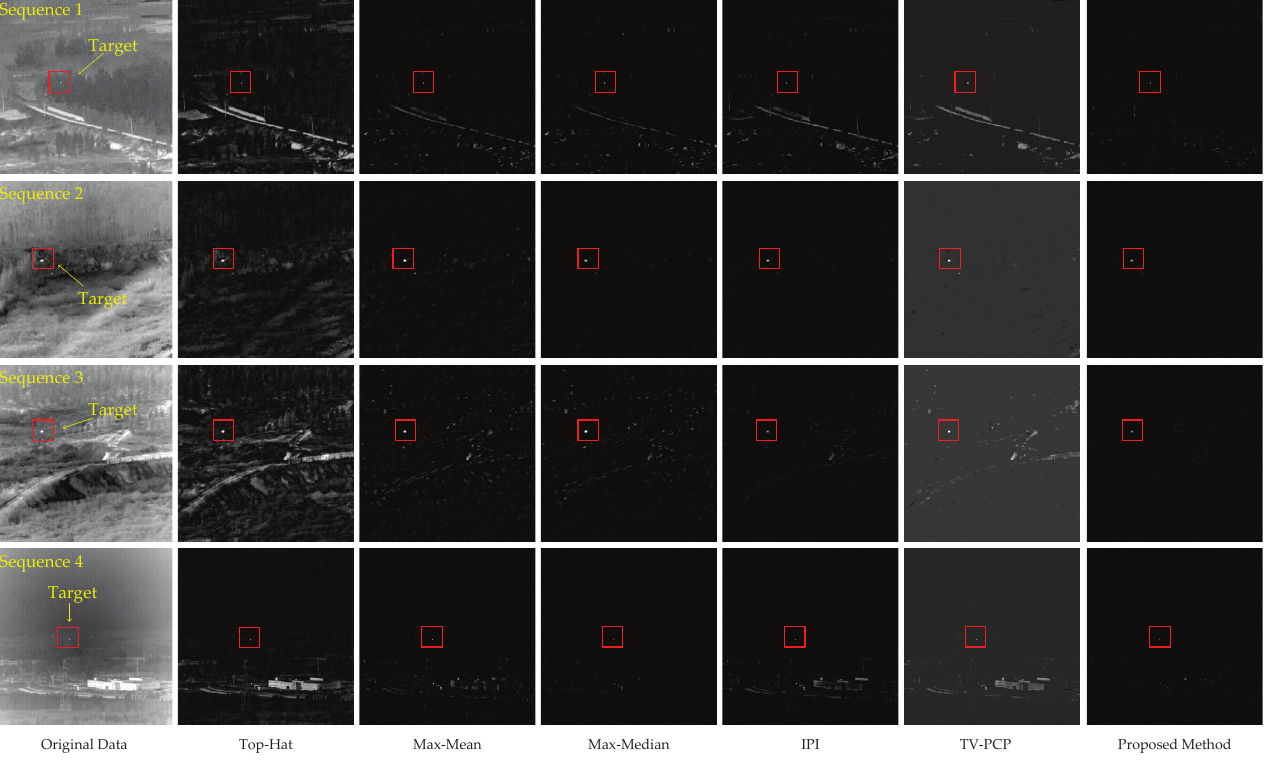
Figure 7. The representative images of the four real image sequences and the corresponding processed target images of different methods. From left to right are the original data, the processing results of Top-Hat, Max-Mean, Max-Median, IPI, TV-PCP, and the proposed